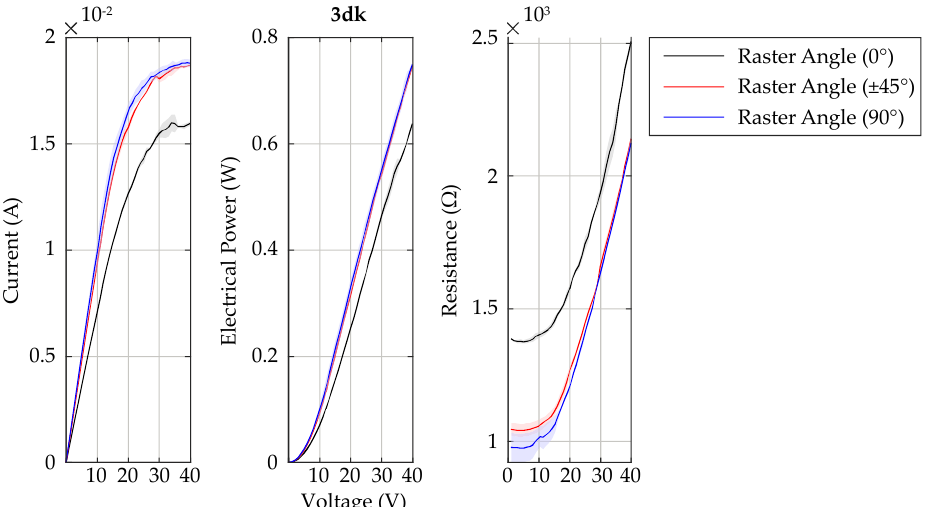
Figure 18. Representation of current, electrical power and resistance depending on voltage of 3dk.